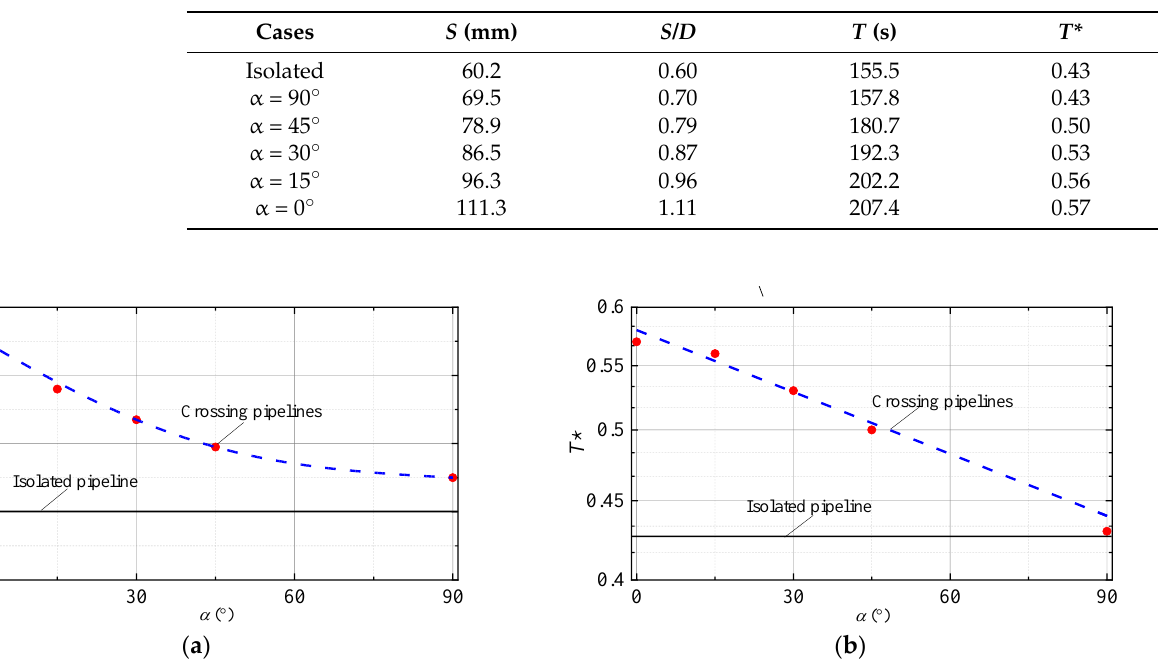
Figure 10. Variations of ( a ) S / D and ( b ) T * with intersecting angle α. Figure 11. Variations of ( a ) S / D and ( b ) T * with intersecting angle α